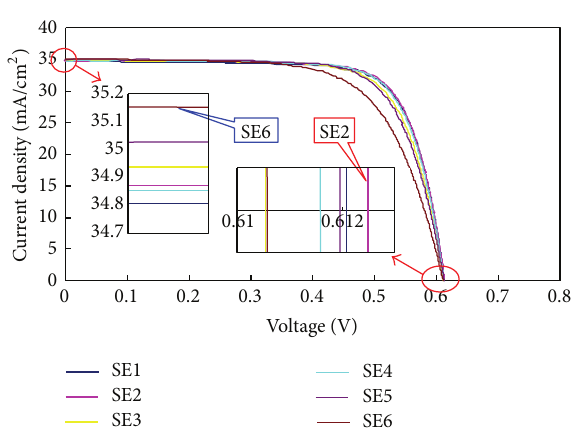
Figure 5: Current density-voltage ( 𝐽 - 𝑉 ) characteristics of SE mc- Si solar cells with different emitter-region sheet resistances under standard measuring conditions (AM 1.5 spectra, 1000 Wm −2 , and 25 ∘ C). The insets are enlargements of the 𝐽